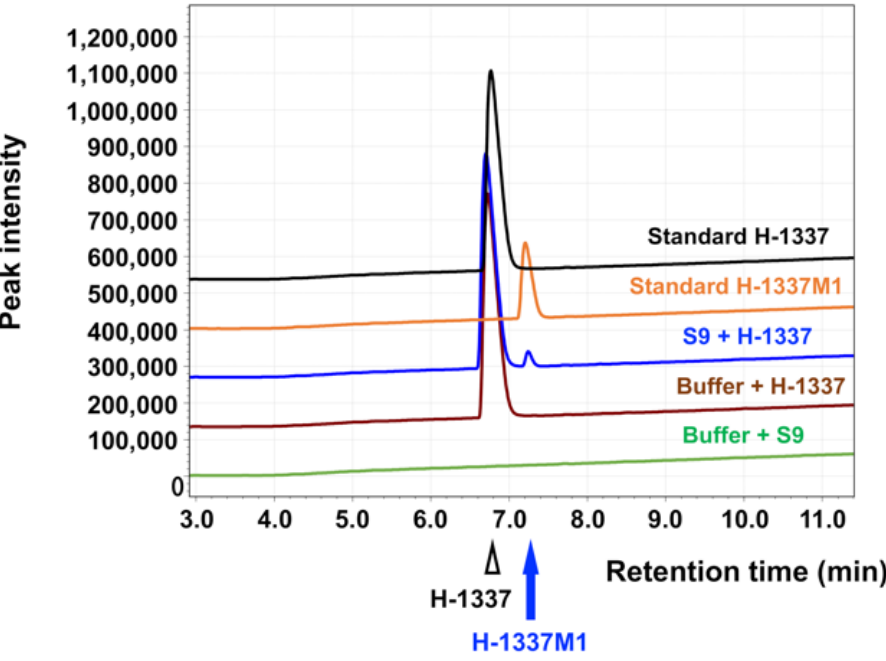
Figure 1. Analysis of H-1337M1 using high-performance liquid chromatography. H-1337 was incubated with rabbit liver S9 fraction. A peak distinct from that of H-1337 was detected (blue). The metabolite was named as H-1337M1 by the authors. Table 1. Kinase inhibition profiles of H-1337 and H-1337M1.